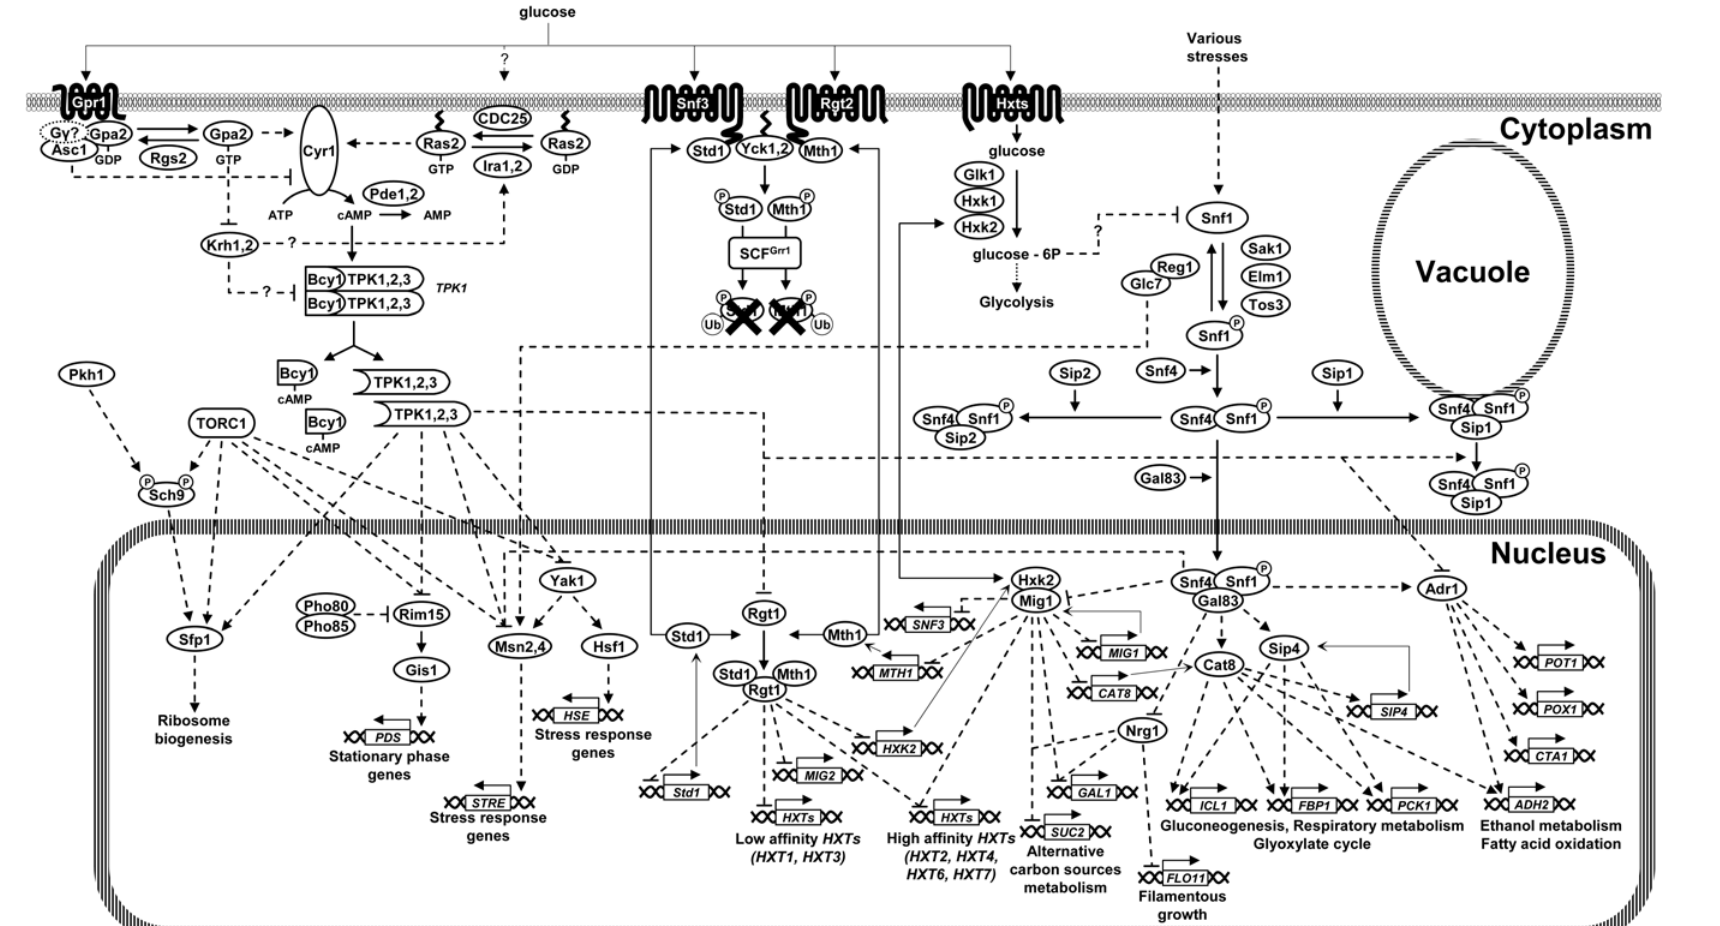
Figure 3. A simplified view of the glucose sensing mechanisms in S. cerevisiae. A schematic view of the three glucose sensing pathways in yeast. The major interconnections with the TOR pathway (only partially shown) are indicated. See text for